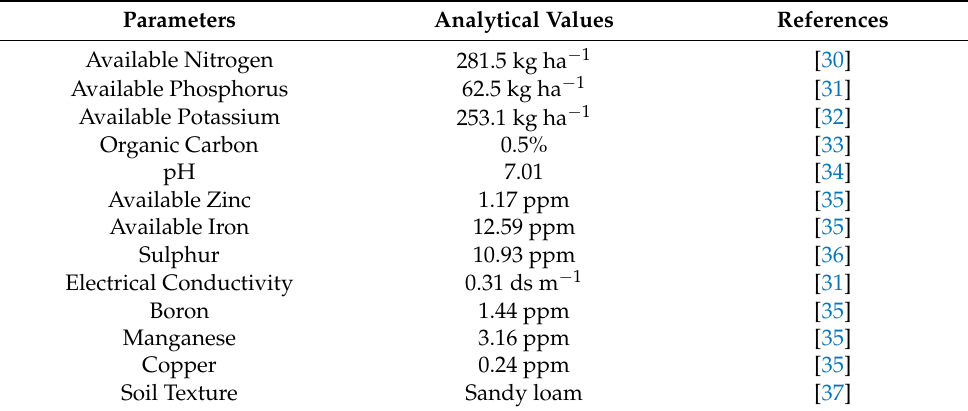
Table 1. Initial soil characteristics of the experimental soil (0–20 cm depth) of the Field.